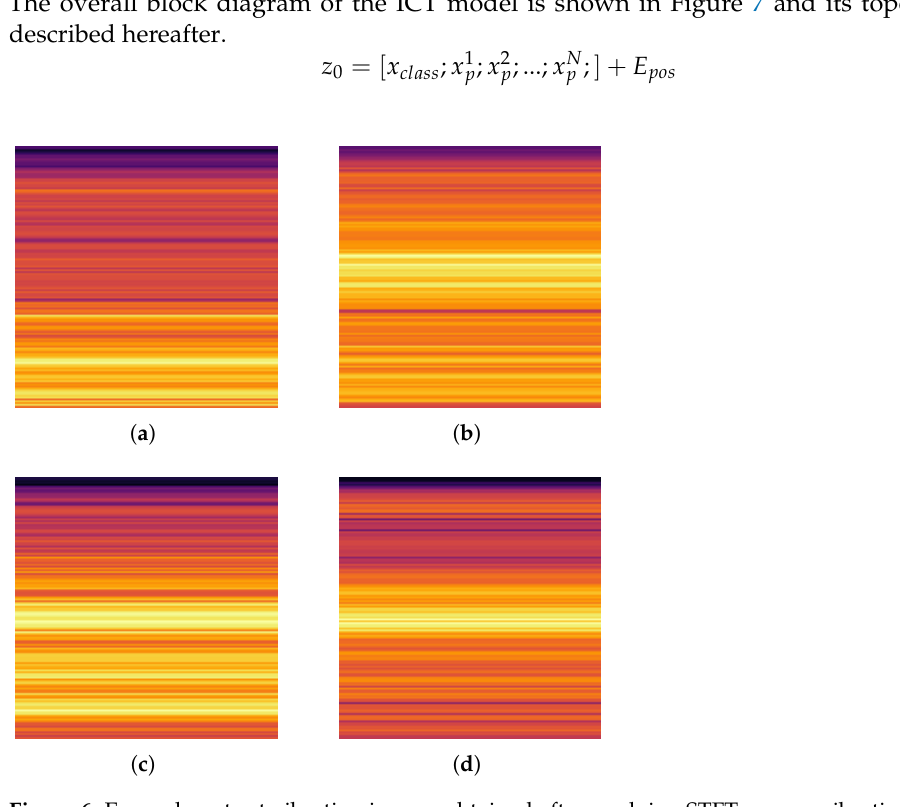
Figure 6. Example output vibration images obtained after applying STFT on raw vibration signals: